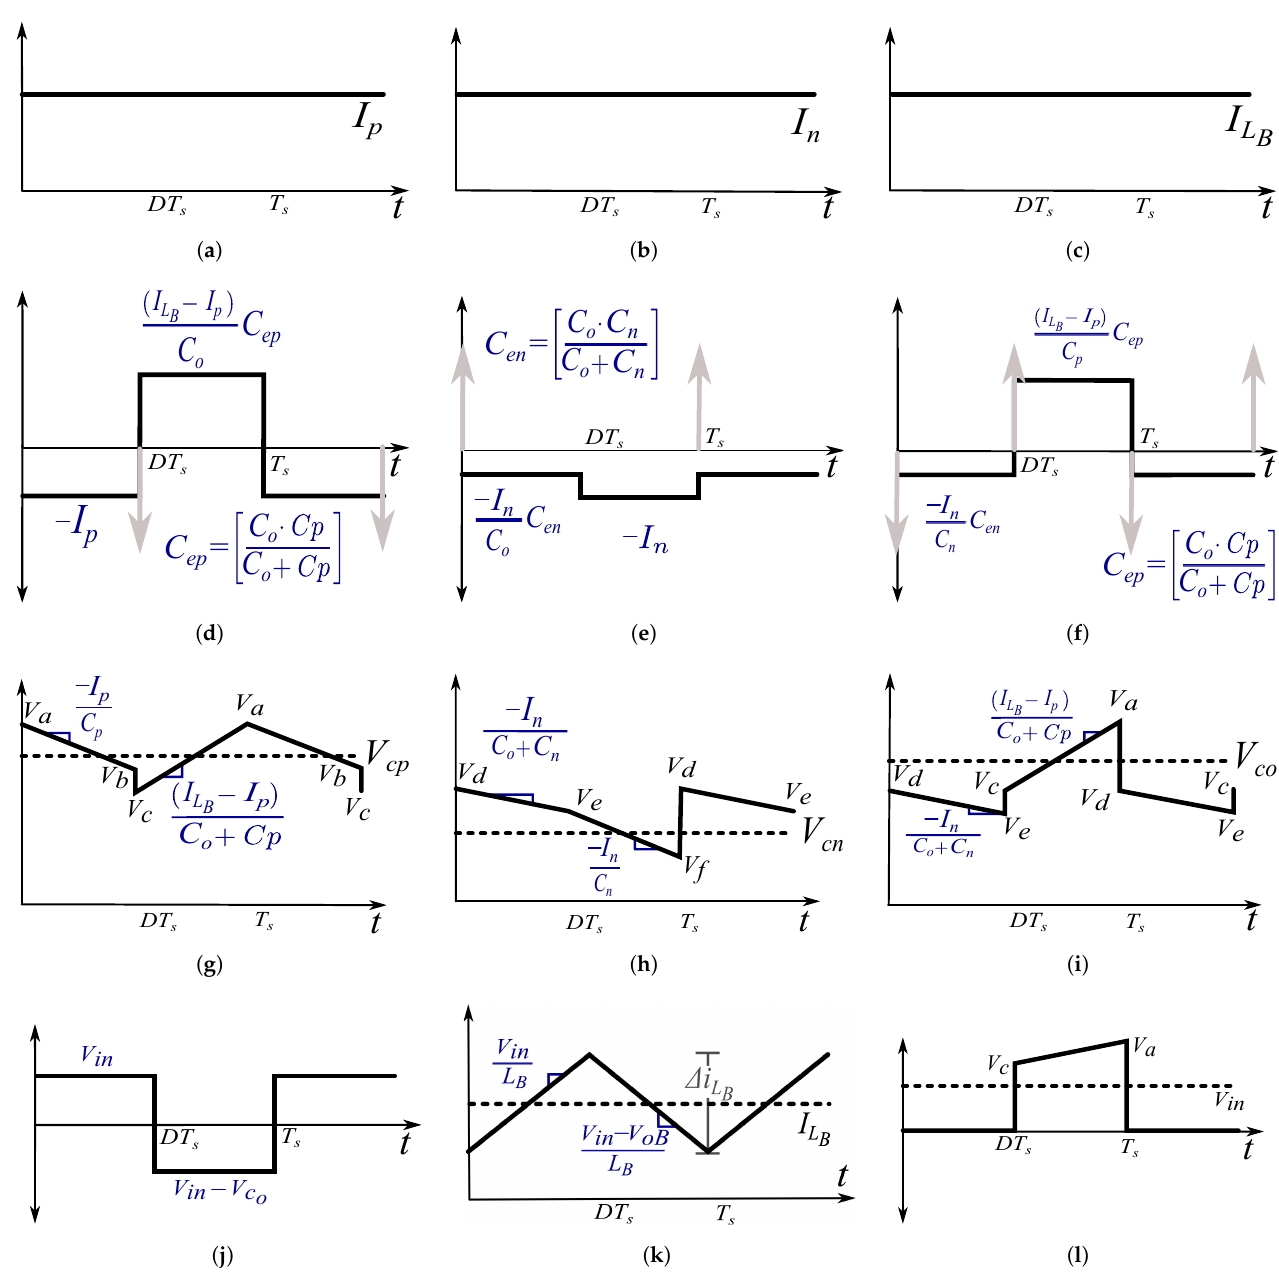
Figure 5. Main current and voltage waveforms of the converter in steady-state using small ripple approximation. ( a ) i p ( t ) , ( t ) with small ripple approximation. ( d ) i cp ( t ) , ( e ) i cn ( t ) , ( f ) i co ( t ) , ( g ) v cp ( t ) , ( h ) v cn ( t ) , ( i ) v co ( t ) , ( j ) v ( b ) i n ( t ) , ( c ) i L B ( t ) without small ripple approximation. ( l ) v ( k ) i L B